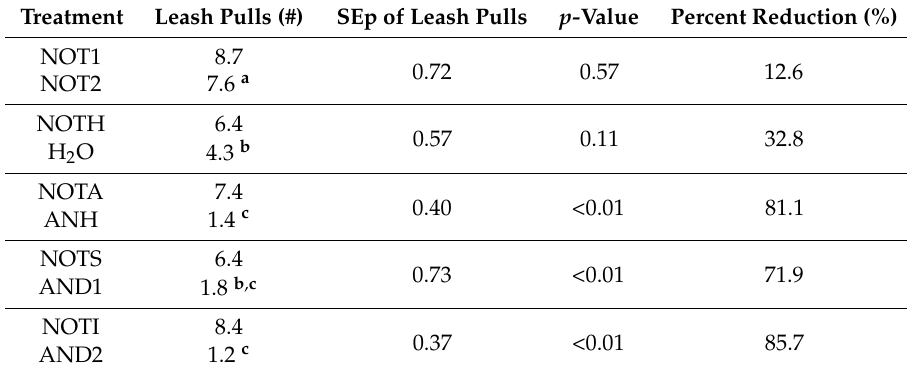
Table 3. Comparison of average number of leash pulls for dogs receiving no correction (NOT1) vs. no correction (NOT2), no correction (NOTH) vs. water only spray (H 2 O), no correction (NOTA) vs. androstenone + water spray (ANH), no correction (NOTS) vs. androstenone 0.1 µ g/mL (AND1), or no correction (NOTI) vs. androstenone 1.0 µ g/mL (AND2) in response to each pull. n = 10 dogs/treatment. Treatment Leash Pulls (#) SEp of Leash Pulls p- Value Percent Reduction (%) NOT1